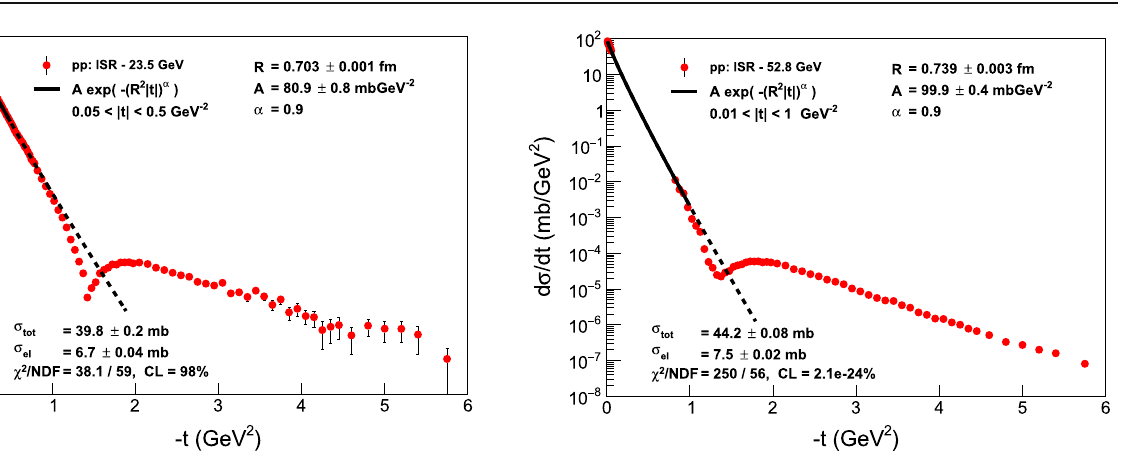
Fig. 36 Zeroth-order Lévy fits to the cone region of the differential cross-section data on pp elastic scattering at with fixed α = 0 . 9, A and R being free fit parameters